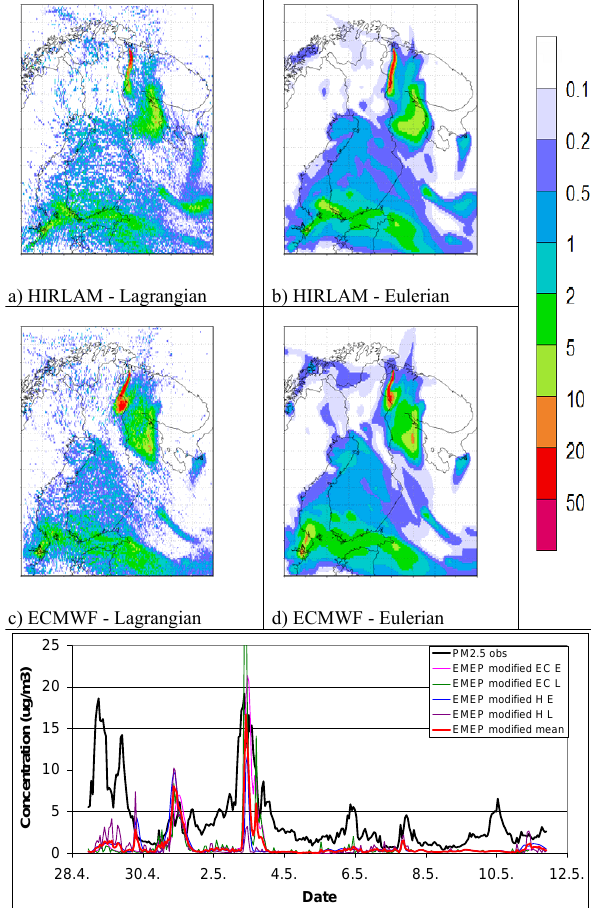
Fig. 7. Surface-level concentrations of PM 2 . 5 , 00:00 at 3 May 2003, Figure 7. Surface-level concentrations of PM2.5, 0:00 at May 3, 2003, calculated with revised calculated with revised EMEP emissions. Panels: (a) Lagrangian EMEP emissions a) Panels: a) Lagrangian SILAM, HIRLAM meteo, b) Eulerian SILAM, HIRLAM meteo, c) Lagrangian SILAM, ECMWF meteo, d) Eulerian SILAM, ECMWF SILAM, HIRLAM meteo, (b) Eulerian SILAM, HIRLAM me- meteo, e) time series for all four computations and Varrio PM2.5 observations. teo, (c) Lagrangian SILAM, ECMWF meteo, (d) Eulerian SILAM, ECMWF meteo, (e) time series for all four computations and Varrio PM 2 . 5